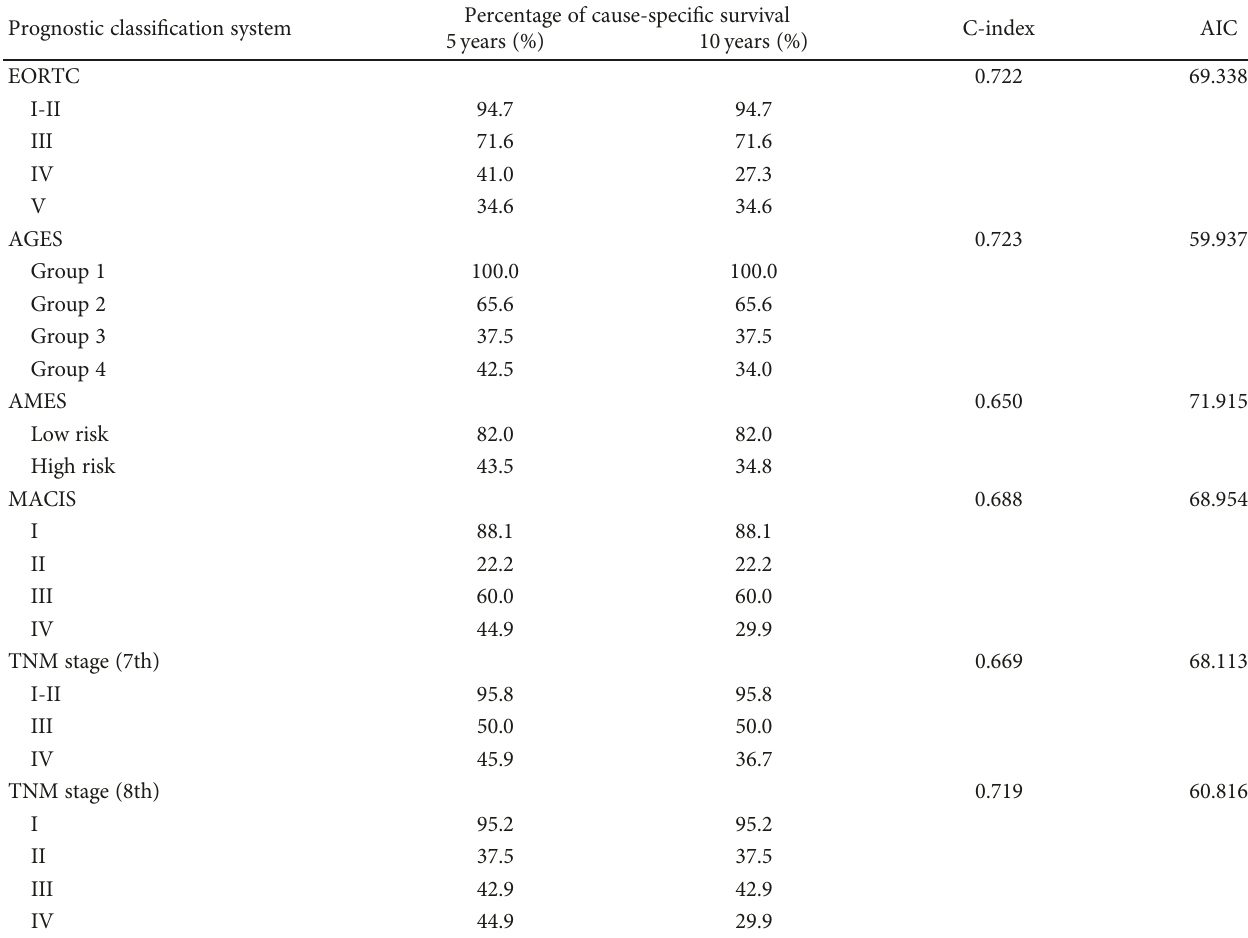
Table 4: Comparison of prognostic classi fi cation systems in WDTC patients harboring dedi ff erentiated phenotype. Prognostic classi fi cation